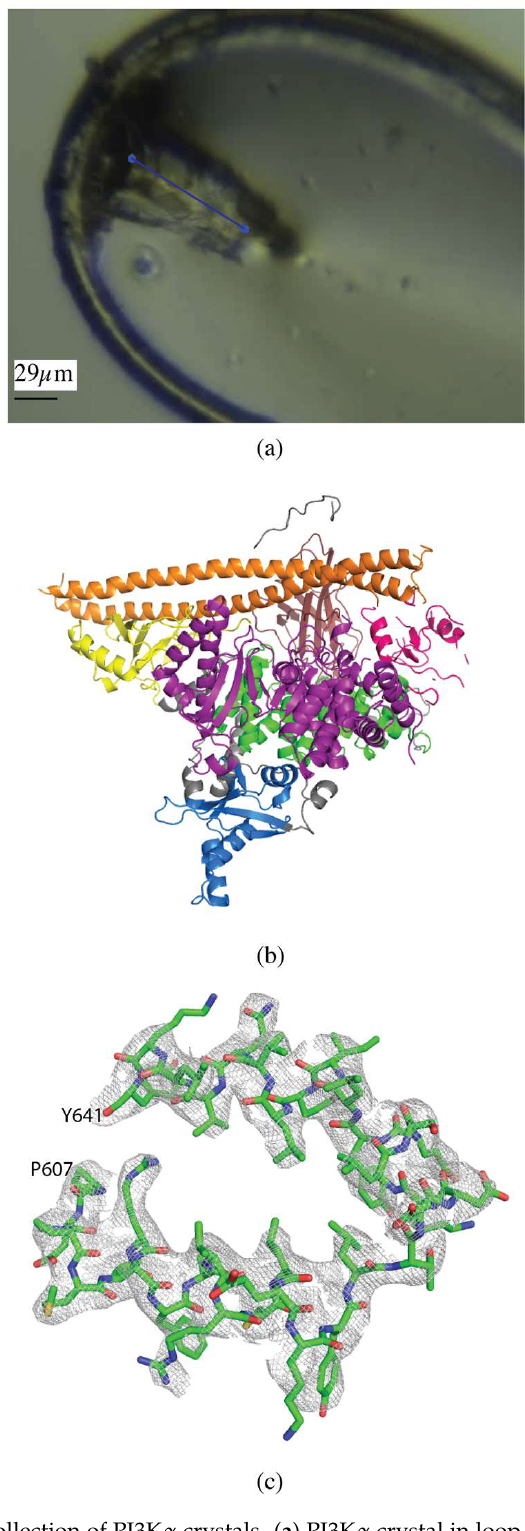
Figure 2. Vector data collection of PI3K α crystals. ( a ) PI3K α crystal in loop with the vector for data collection shown as a blue line. ( b ) Overall structure of PI3K α , colored by domain (PDB ID 6NCT). ( c ) 2mFo-DFc map of a section of the helical domain of the PI3K α structure contoured at 1.0 σ.